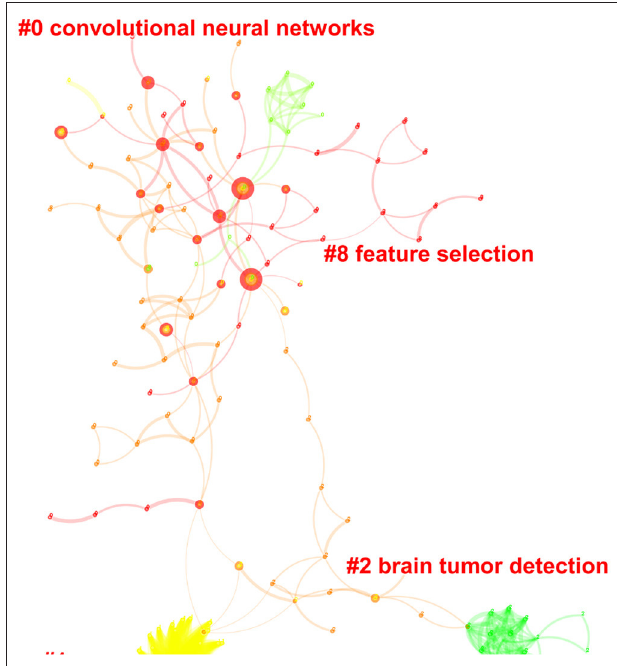
FIGURE 6 | Clusters of research in the area of digital health in the Arab world.